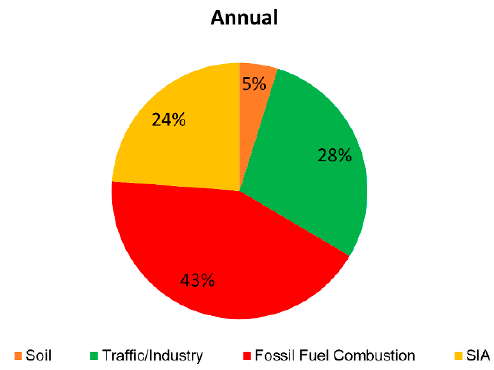
Figure 6. The average annual contribution of sources to PM2.5 mass in %.